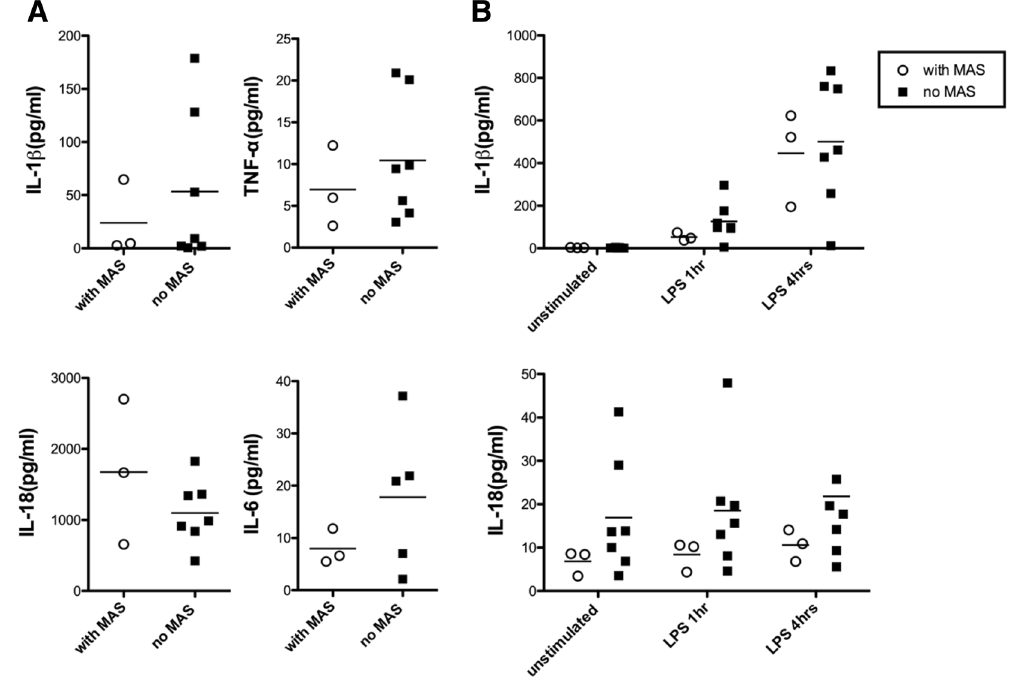
Figure 3. Plasma cytokine levels and PBMC responses to in vitro stimulations test among sJIA patients with and without a history of MAS. Levels of plasma cytokines and responses to in vitro stimulations tests are comparable among sJIA patients regardless of the propensity of MAS. ( A ) Levels of IL-1β, IL-6, IL-18 and TNF-α were measured and compared between sJIA cases with and without a history of MAS. ( B ) IL-1β and IL-18 secretion were measured in the supernatant of PBMCs isolated from patients with sJIA with medium only and 1 and 4 h after LPS stimulation. Results between those with and without a history of MAS were compared. Data are presented with dot plot with means. Abbreviations: sJIA-systemic juvenile idiopathic arthritis; MAS- macrophage activation syndrome; IL-1β- interleukin 1β; IL-6- interleukin 6; IL-18- interleukin 18; TNF ⍺